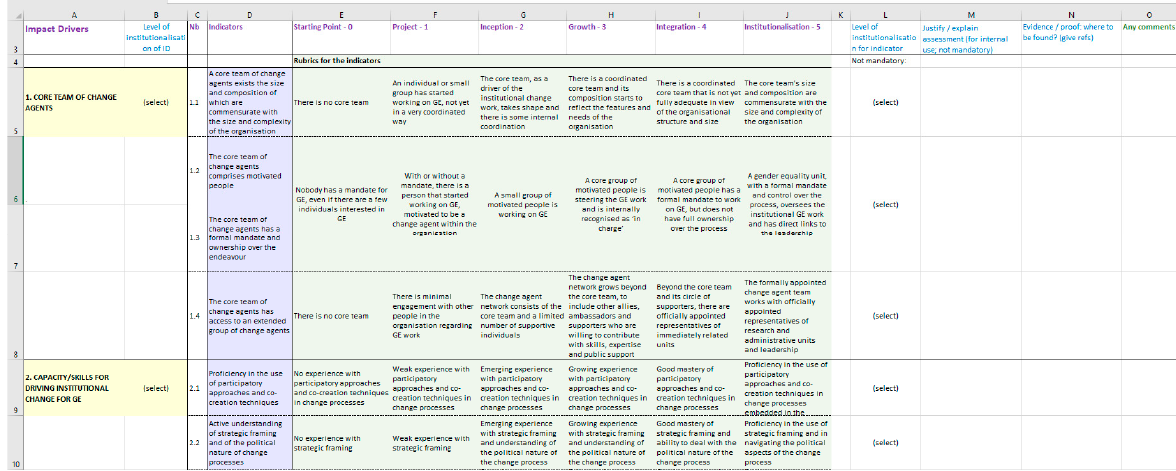
Figure 4. Image of first sheet of the tool (excerpt).